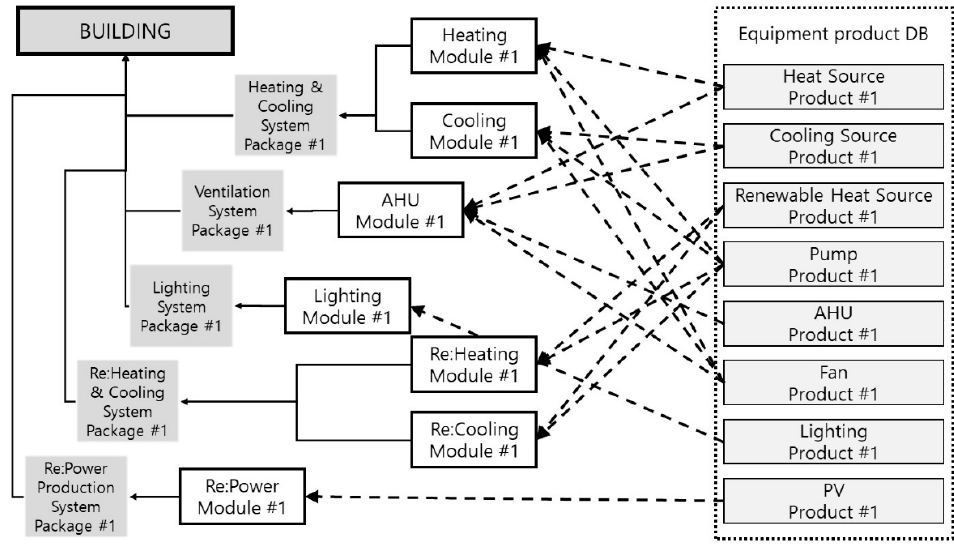
Figure 3. Active package composition.